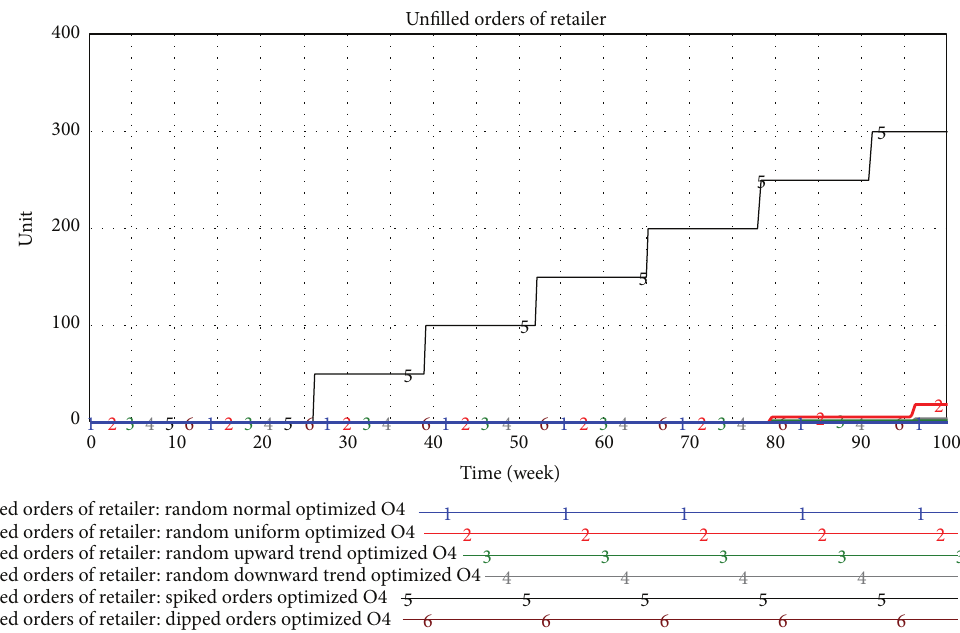
Figure 9: Unfilled orders at retailer despite higher weight for unfilled order component in the objective under Optimization 4.